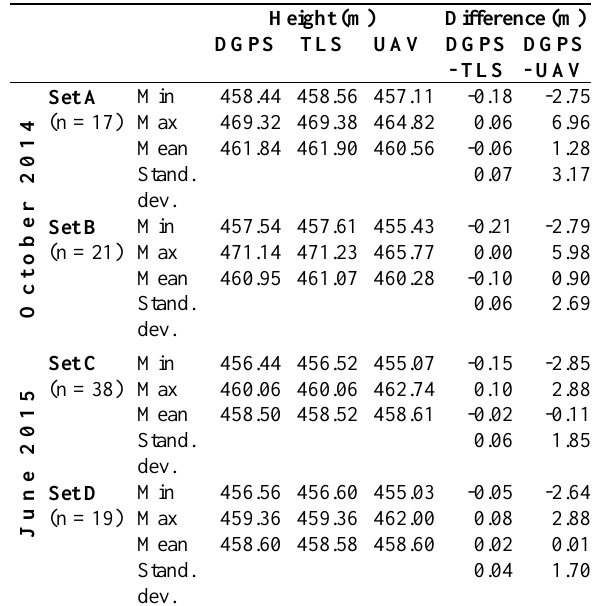
and June 2015 from TLS-derived (top) and UAV- derived (bottom)